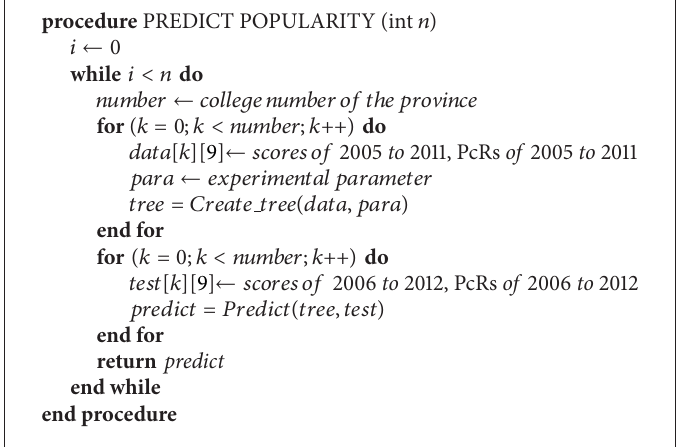
Algorithm 1: Using decision tree to predict Chinese colleges’ popularity.